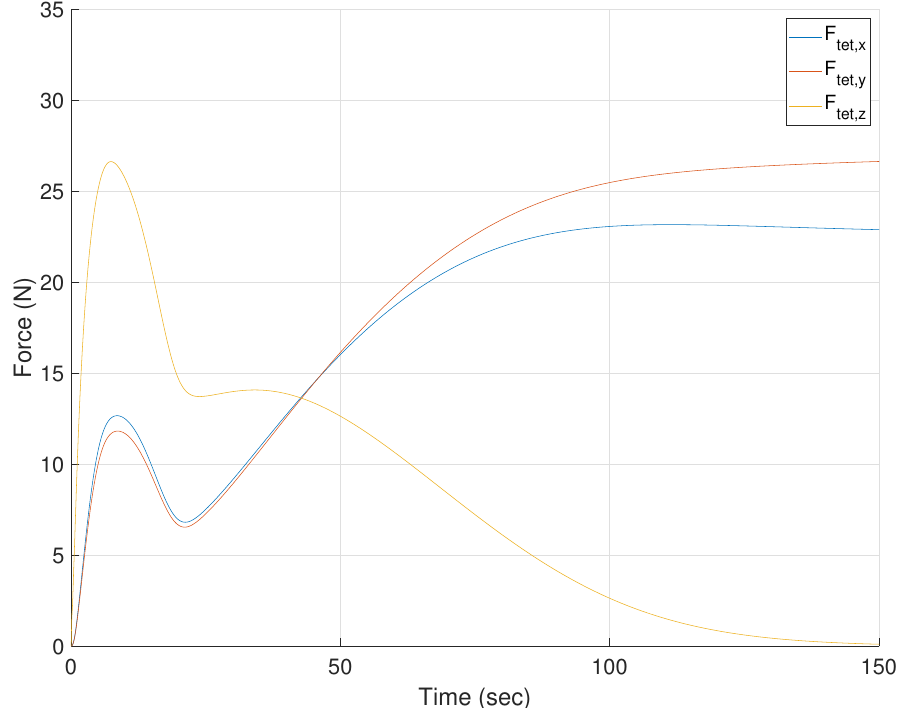
Figure 9. Tether force in n -frame on the free floating ROV, current velocity of [ 0.3536,0.3536,0 ] in the n